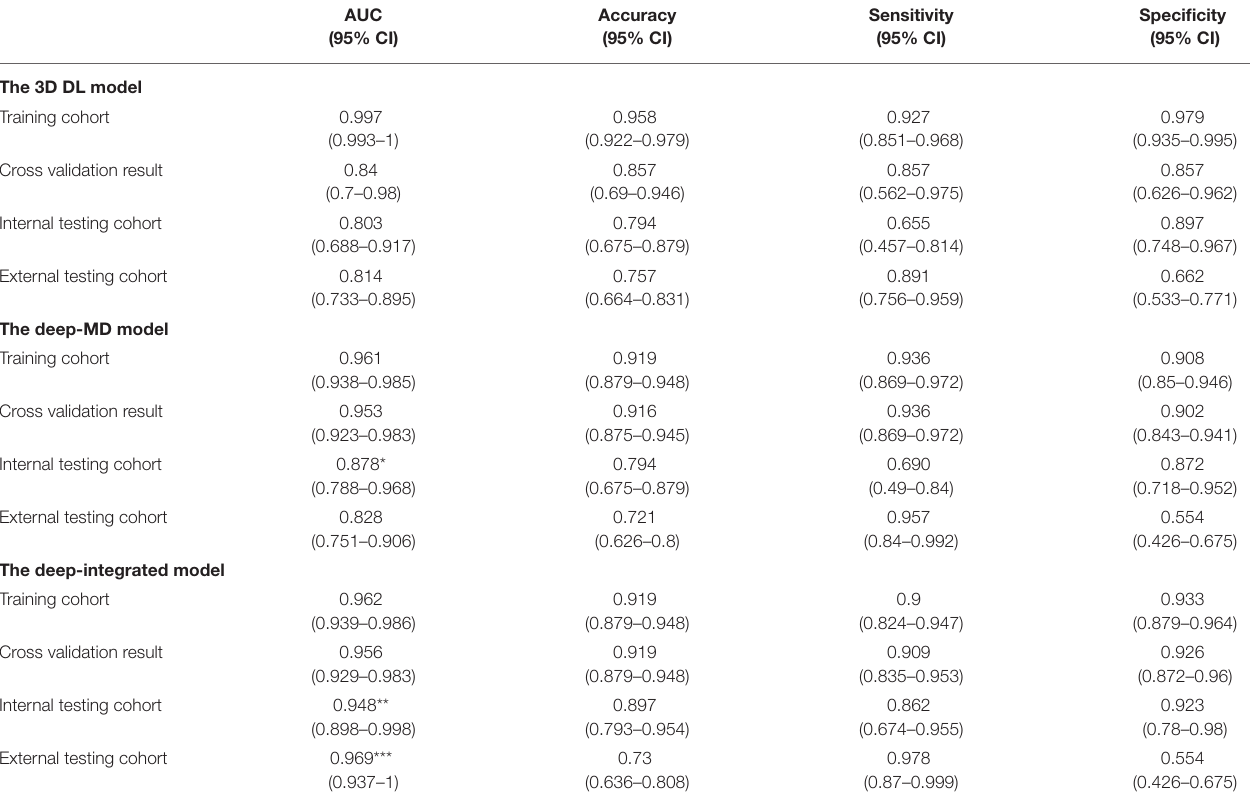
TABLE 2 | Detailed aortic dissection (AD) detection performance results of the